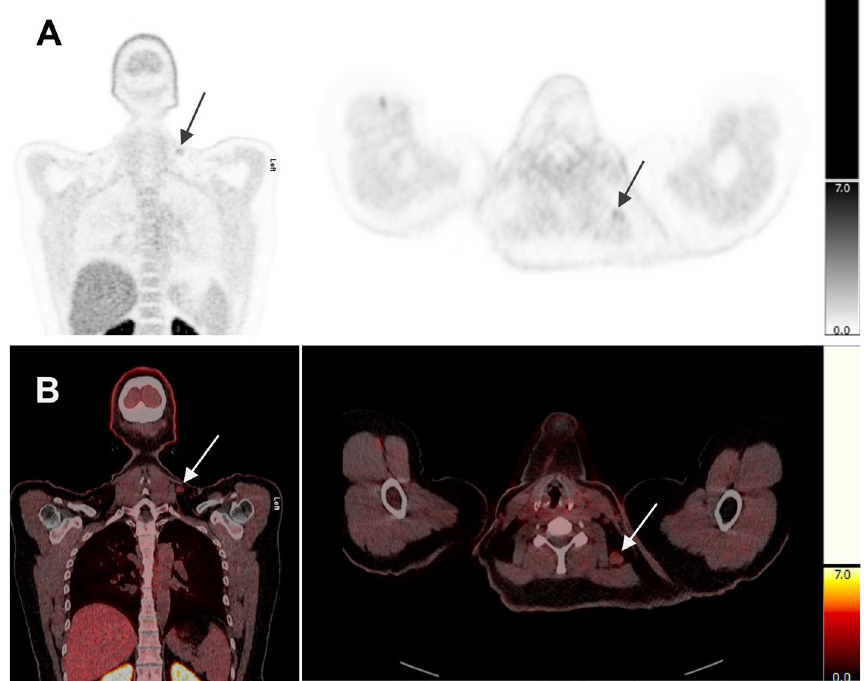
Fig. 2 A 40-year-old woman (patient 9). Coronal and axial PET A and fused PET/CT B images showing slightly increased [ 18 F]FDOPA uptake in a cervical lymph node (SUV max biopsy showed reactive changes and no